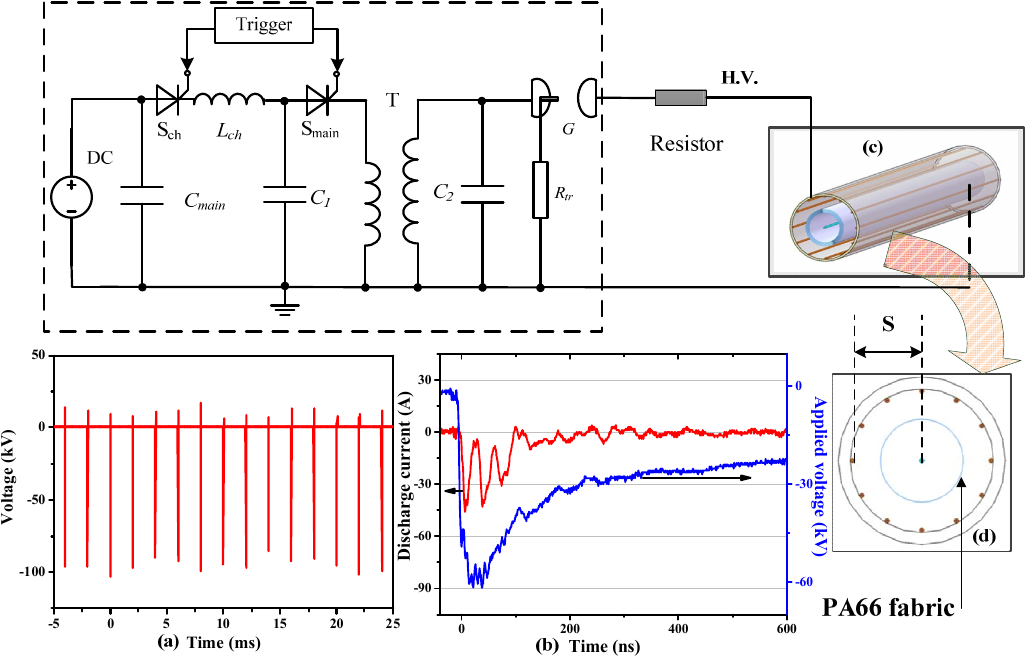
Figure 2. Schematic diagram of the reactor: ( a ) The output pulse voltage waveform; ( b ) The typical voltage and current waveforms; ( c ) The 3D view (the orange electrodes are the high-voltage terminals and the blue one is the ground pole. The blue barrels represent the fabrics waiting to be processed); ( d ) Side view of the position of the PA66 fabrics to be treated.